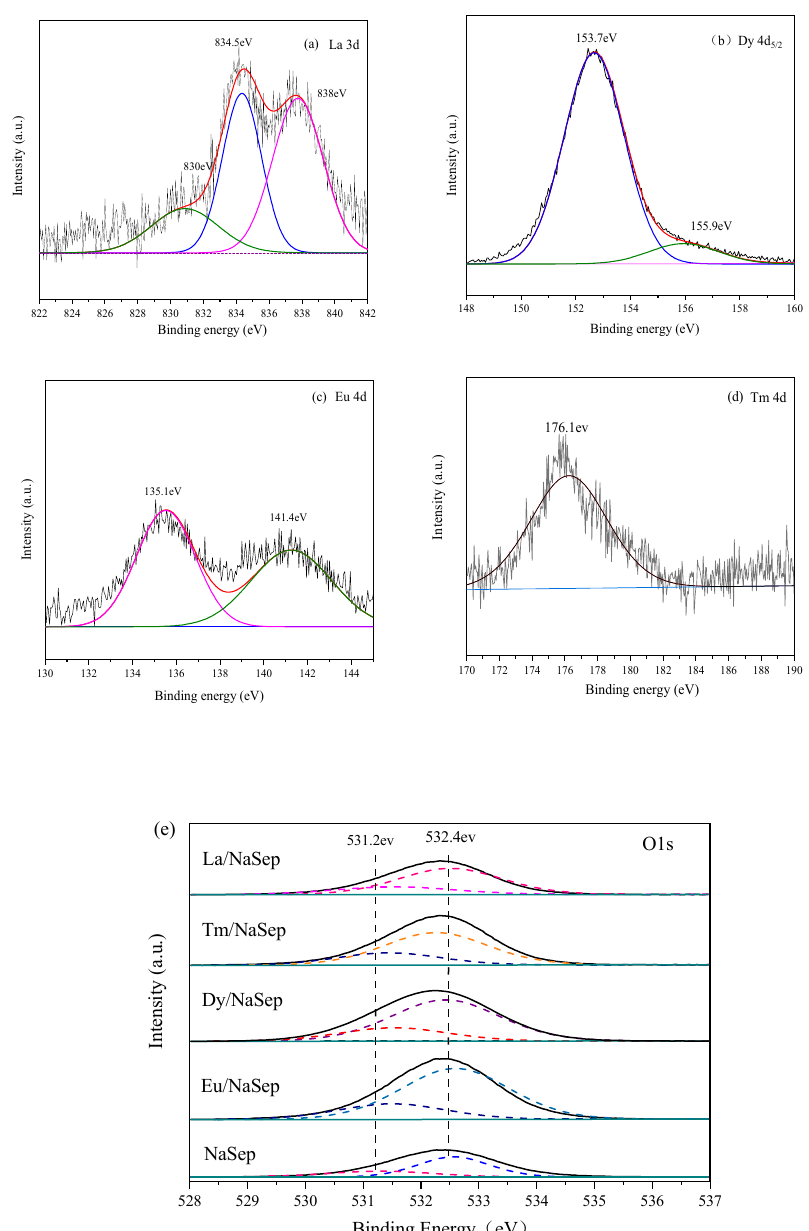
Figure 5. ( a ) La 3d, ( b ) Dy 4d 5 / 2 , ( c ) Eu 4d, ( d ) Tm 3d, and ( e ) O 1s XPS spectra of the samples.